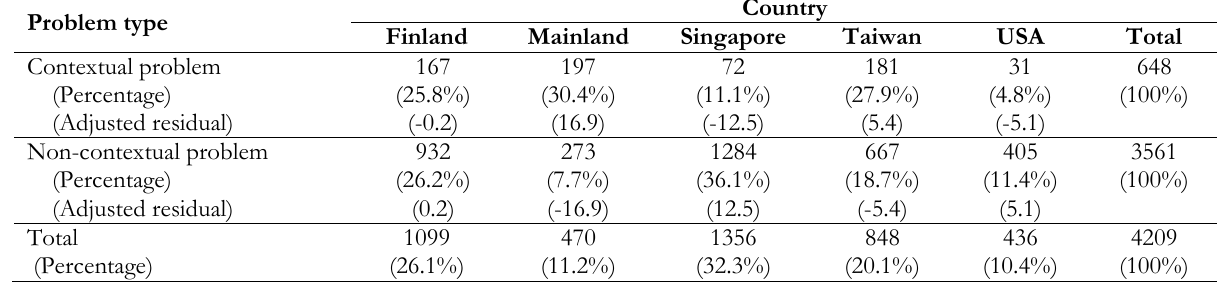
Table 2. Cross-tabulation of problem type and country with adjusted